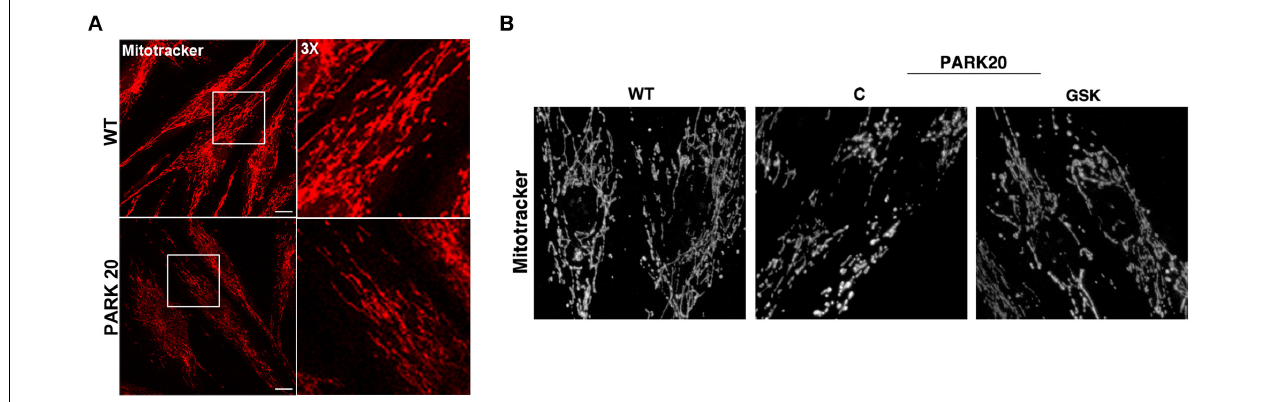
FIGURE 6 | Mitochondrial network is altered in PARK20 fibroblasts. HDF (WT) and PARK20 cells were seeded on glass coverslips and stained with the mitotracker red CMXRos probe for 20 min at 37 ◦ C prior to be fixed and processed for immunofluorescence. Serial confocal sections were collected from top and bottom of the cells. Representative images of single confocal sections (A) and 3D reconstructions of Z-stack acquired to higher magnification (B) are shown. Scale bars: 20 µ m.